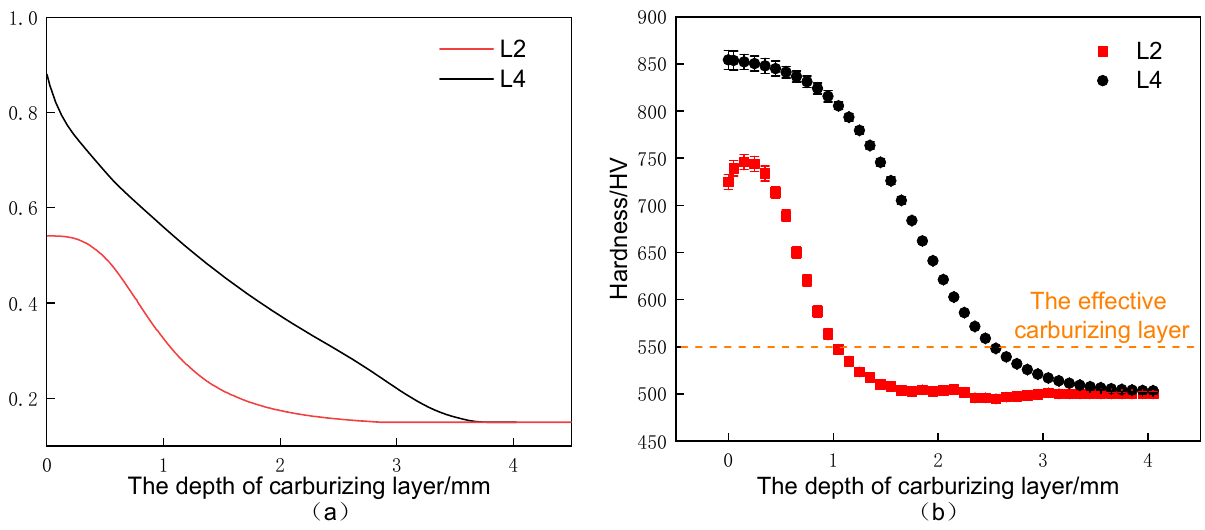
Figure 10. Under different carburizing temperature conditions: ( a ) carbon concentration profile; ( b ) microhardness profile.